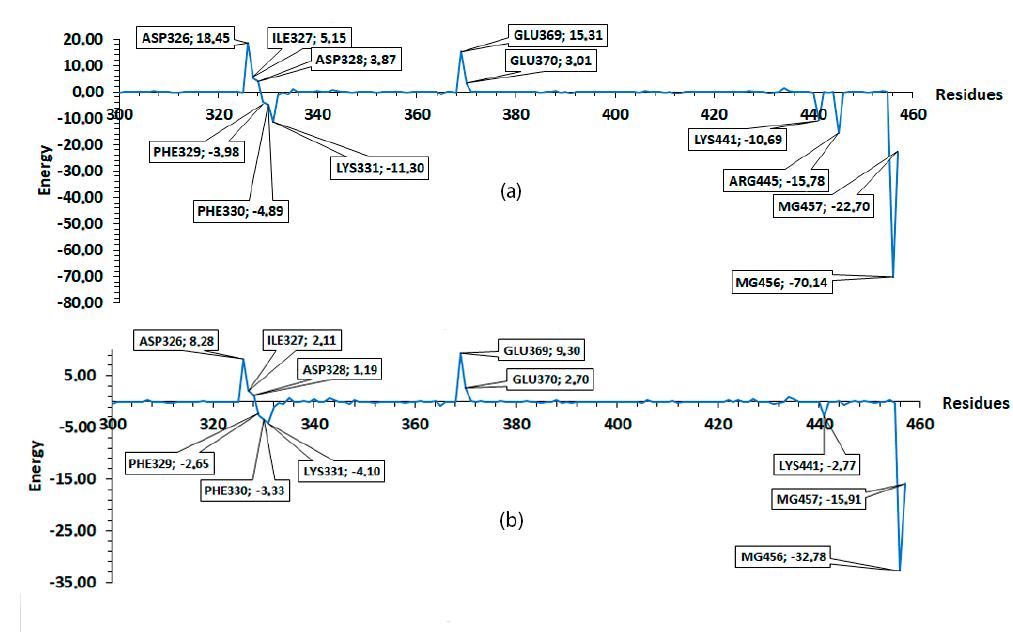
Figure 10. MM/PBSA average ligand binding free energies for 110 ns of simulation. Residues 300 to 457 were considered. ( a ) GTP and ( b )